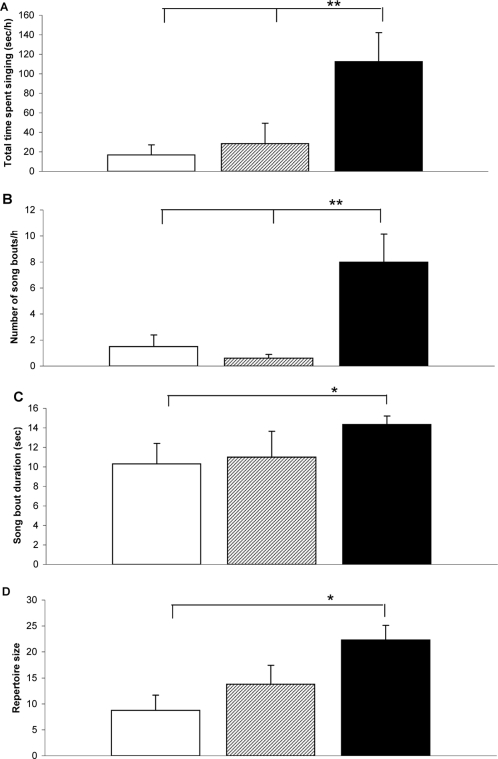
Song production in male starlings exposed to chemicals.The song production of male starlings in three treatment groups: control (open bars); E2 dosed (hatched bars); and the chemical mixture dosed (black bars) (a) Total time spent singing (sec/h). (b) Number of song bouts per hour. (c) Song bout duration (s) d) Repertoire size. Graphs show means+s.e.m. There was a significant effect of the experimental manipulation on the time spent singing between the treatment groups (ANOVA, F2, 24 = 6.15, P = 0.007). Bonferroni pairwise comparison post-hoc tests showed that the males that received the mixture of chemicals spent significantly longer singing than the control males (P = 0.009) and the E2 group (P = 0.028). There was a significant effect of treatment on the number of song bouts sung by the males (ANOVA, F2, 23 = 9.16, P = 0.001). Males in the mixture treatment group sang more song bouts than the control males (P = 0.004) and the E2 males (P = 0.002). Mean song bout duration was significantly longer for males in the mixture treatment group compared to the control males (ANOVA, F1, 11 = 5.842, P = 0.034). Finally, there was a significant effect of the experimental manipulation on the repertoire size of male starlings (ANOVA F2, 16 = 4.39, P = 0.030). The males in the mixture group had significantly greater repertoire size than males in the control group (Bonferroni pairwise comparison post-hoc tests P = 0.042). * = P<0.05; ** = P<0.01.